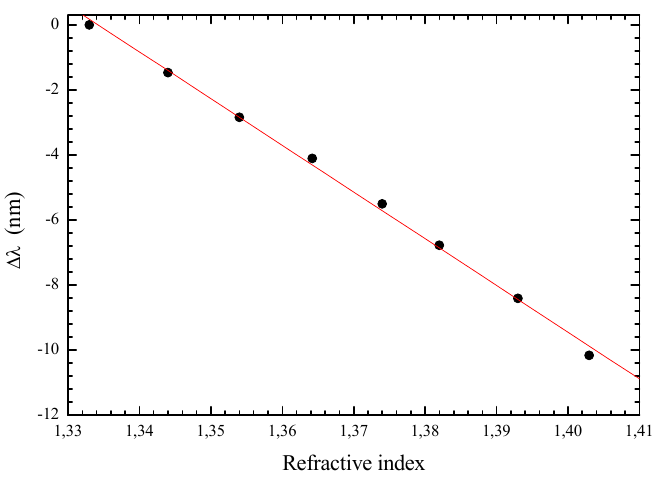
Figure 11. Refractive index measurement using D -type fiber in a fiber loop